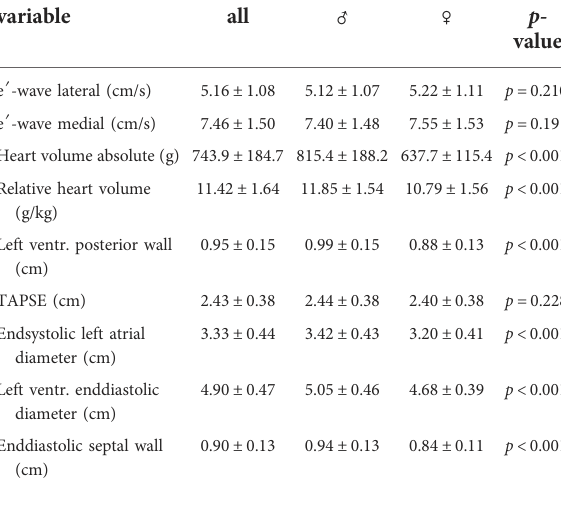
TABLE 2 Echocardiographic characteristics of study population.